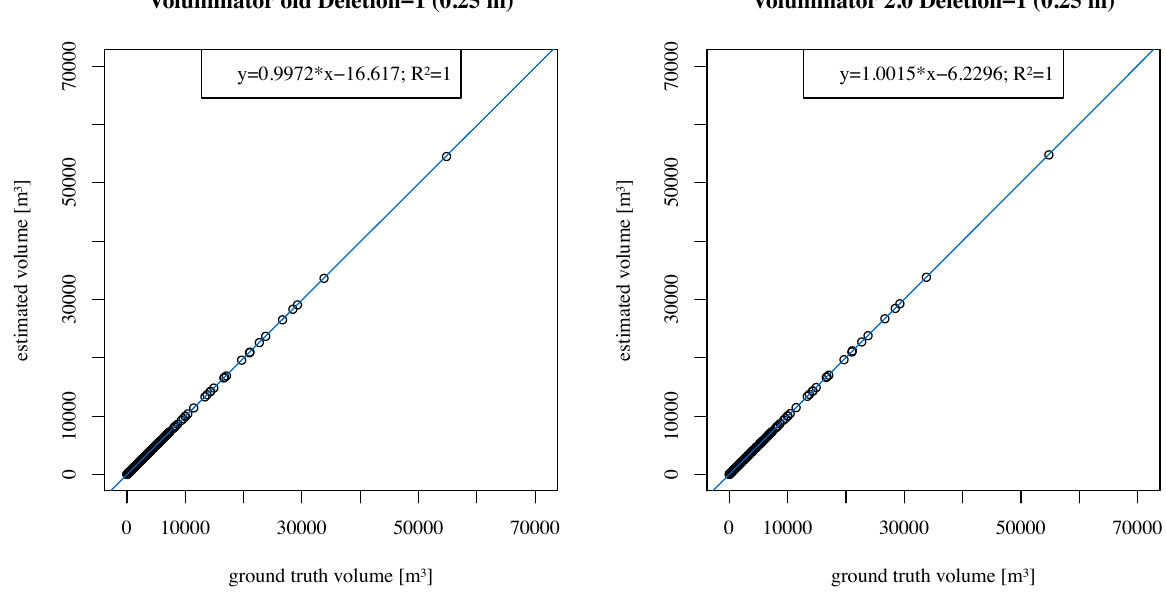
Figure 14: Scatterplot of the actual building volume and the approximated building volume for buildings with defective solid boundaries ( > 5% of the solid boundary is missing; n = 192 buildings) using the old voluminator (left) and the recursive voluminator approach at a resolution of 0 . 25 m . For the old voluminator approach the overall computation time was 763 minutes for the octree approach the overall computation time was 262